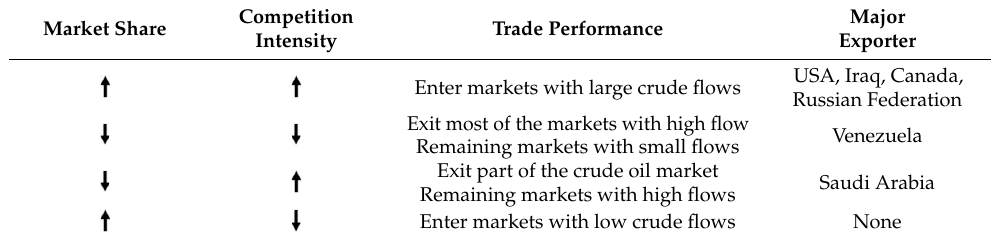
Table 1. The trade performance of major exporters in the crude oil export